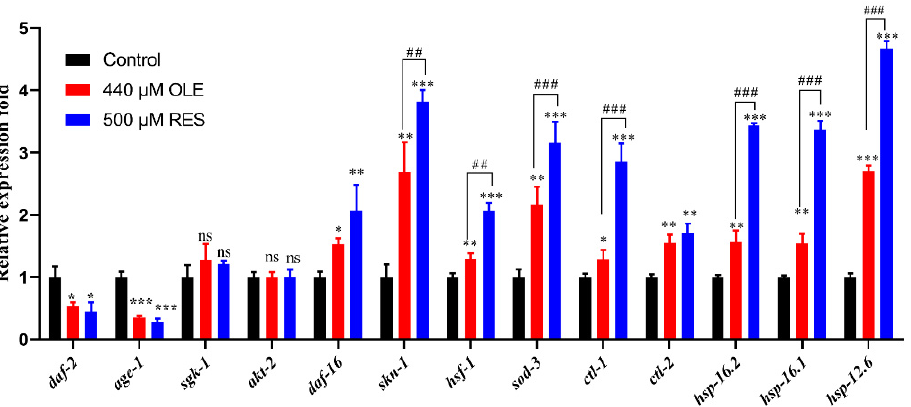
Figure 6. Effect of OLE on gene expression of N2 worms. Gene transcription level normalized to internal control gene act-1 . * p < 0.05, ** p < 0.01, and *** p < 0.001 suggests a significant difference when compared to the control group, while ## p < 0.01 and ### p < 0.001 suggests a significant dif- ference when compared OLE with RES group.